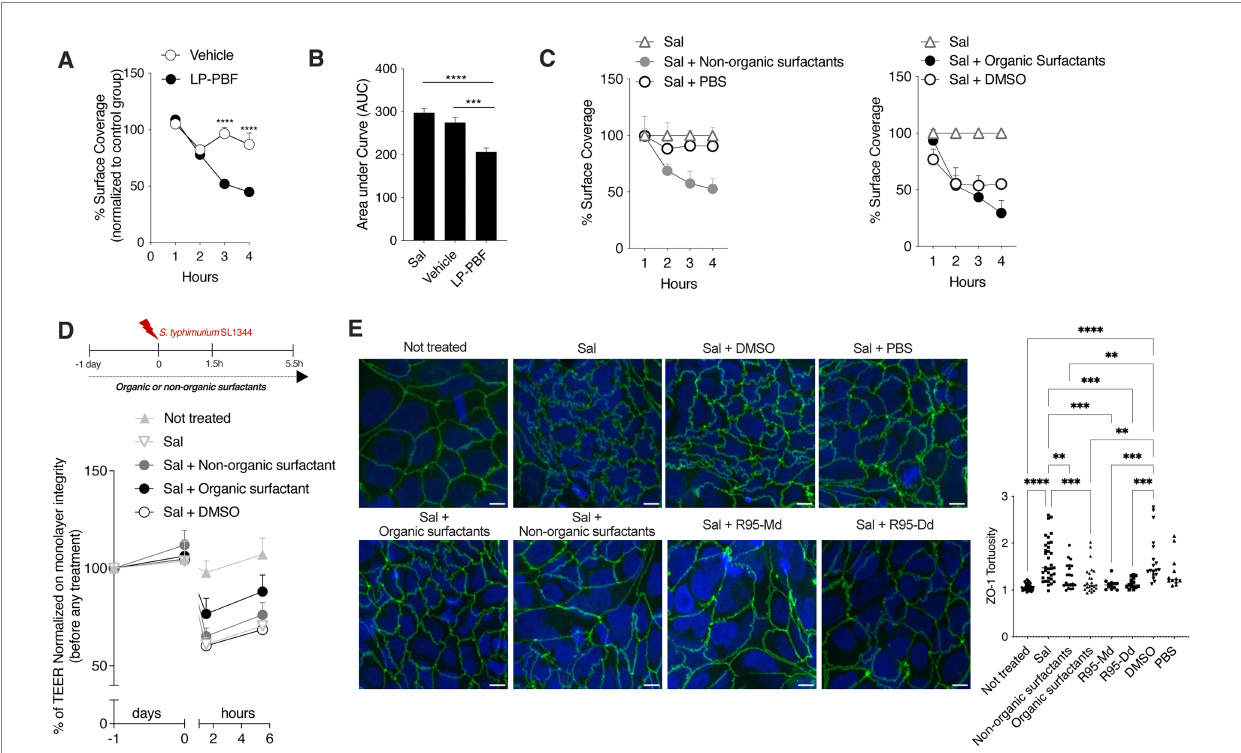
FIGURE 4 Whole LP-PBF postbiotic and its extracted biosurfactants prevent the formation of S. typhimurium biofilm. (A) Graph represent quantification of surface coverage during S. typhimurium SL1344 biofilm formation in two different experimental groups in the presence of whole LP-PBF postbiotic or vehicle. Values represented are normalized to the control S. typhimurium group: vehicle and postbiotic treatment during the time course of 4 h. * Statistical analysis was evaluated using Two-way ANOVA, Tukey’s multiple comparisons test. (B) Quantification of area under the curve (AuC) calculated on the graph (A) . * Statistical analysis was evaluated using Two-way ANOVA, Tukey’s multiple comparisons test. (C) Graph represent quantification of surface coverage during S. typhimurium SL1344 biofilm formation in two different experimental groups in the presence of surfactants extracted from LP-PBF. Values represented are normalized to the control S. typhimurium group: Organic surfactants and DMSO control (left) and non-organic surfactants and PBS (right) treatment during the time course of 4 h. * Statistical analysis was evaluated using One-way ANOVA, Tukey’s multiple comparisons test. (D) TEER values of Caco-2 cells pretreated overnight with organic/non-organic biosurfactants/DMSO, followed by infection with S. typhimurium SL1344. Infected Caco-2 cells were left for 4 h in recovery phase with the presence of biosurfactants or the control. Above schematic representation of the experimental design. (E) Representative immunofluorescence images of ZO-1 done on Caco-2 cells after 1.5 h of S. typhimurium SL1344 infection together with controls (DMSO and PBS), organic or non-organic surfactants, and commercially available rhamnolipids: mono-rhamnolipids (R95-Md) or di-rhamnolipids (R95-Dd). Graph on the right represents quantification of ZO-1 junction tortuosity—ratio between junction length and Euclidean distance between its ends. * Statistical analysis was evaluated using One-way ANOVA, Tukey’s multiple comparisons test. * p -value < 0.05; ** p -value